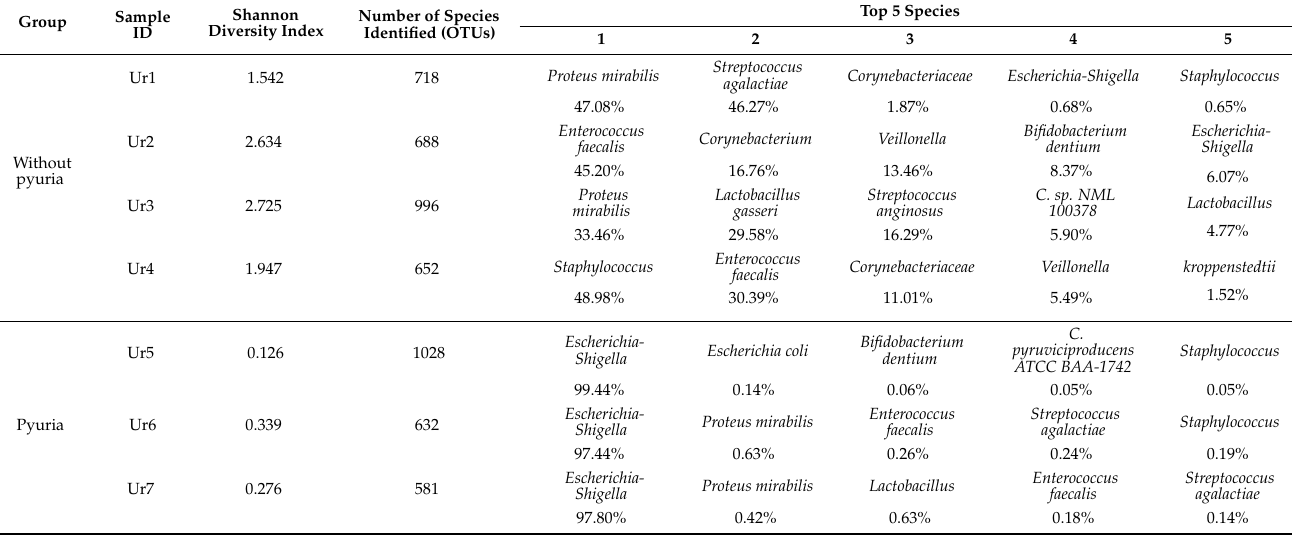
Figure 1. Comparison between the without-pyuria and pyuria groups for the number of OTUs ( A ) and the Shannon diversity index ( B ) in T2D patients treated with SGLT2 inhibitor. ** p < 0.01. Interestingly, the 16S metagenomic sequencing data showed that Escherichia-Shigella spp. accounted for 97.4–99.4% of all species in the pyuria group (Figure 2, Table 2). Proteus mirabilis , Enterococcus faecalis , and Staphylococcus spp. were the three major species in the non-pyuria group (Table 2). These findings highlighted clear differences in the taxonomic composition of microbial communities from the two groups.